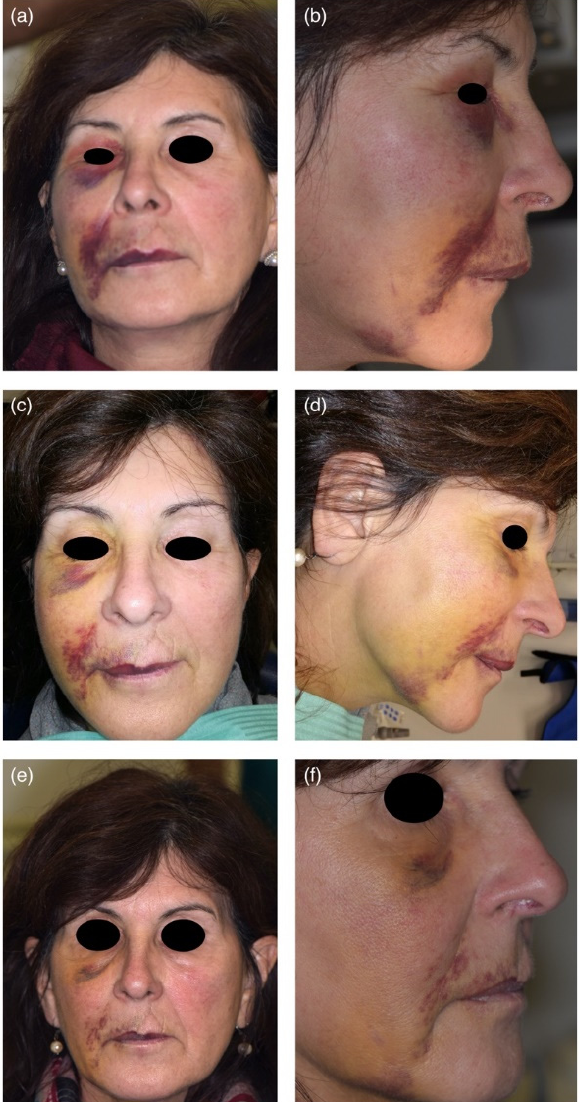
Figure 1. First case: extraoral clinical manifestations of NaOCl Accident. ( a , b ) Day 1. ( c , d ) Day 3. ( e , f ) Day 5.